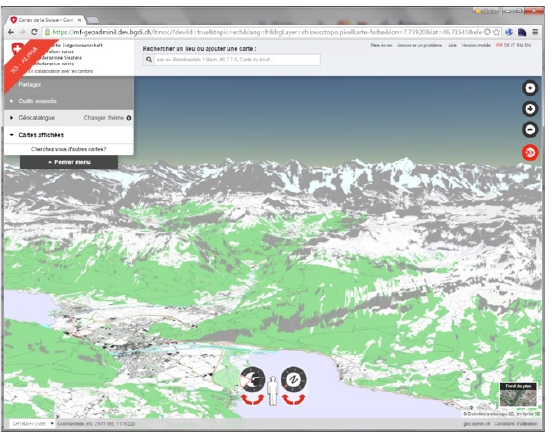
Figure 11 Preliminary 3D viewer on the federal geoportal of Switzerland 8. 3D NATIONAL MAPPING IN THE NETHERLANDS